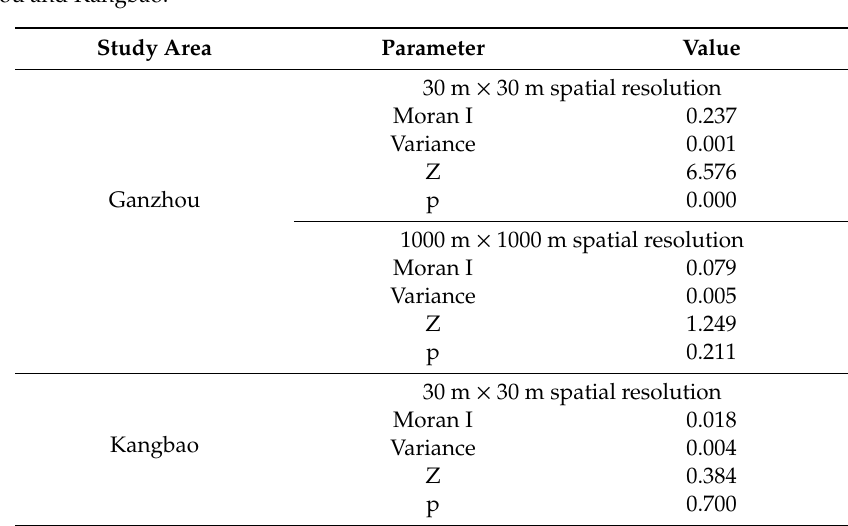
Table 6. Spatial autocorrelation statistical results of the residuals obtained from modified kNN in Ganzhou and